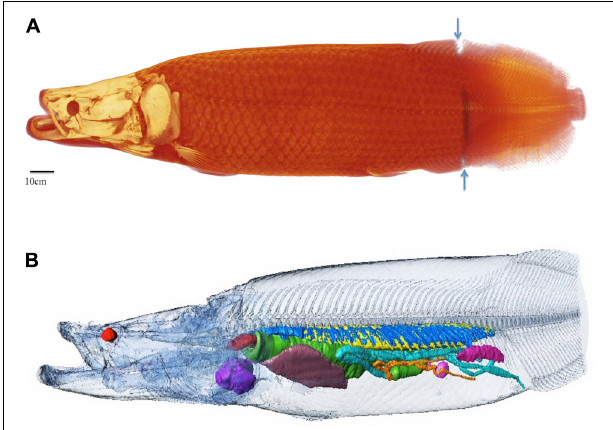
FIGURE 1 | Overview of specimen one. In all figures the traditional radiological convention is adopted with rostral end of fish to the left of the page for sagittal and coronal images and 3D reconstructions. For axial images, left side of image is right side of fish. Right (R), left (L), dorsal (D), ventral (V) marked for clarity. (A) 190 cm long female arapaima weighing 70.5 kg, volume of 68.85lt. The average density of the whole specimen is 1.02 g/cm 3 . Whole fish surface reconstructed from CT and MRI data (CT cranial 85% MRI caudal 15% as demarcated by blue arrows). (B) Semi transparent surface outline showing relative position of internal organs and skeleton reconstructed from CT data. Heart: purple, liver: brown, spleens: pink, ovary: magenta, esophagus and stomach: green, gut: turquoise, pyloric caeca: orange, respiratory tissue: blue, air in gas bladder: yellow, esophageal sphincter: red. Axial skeleton head and body surface: